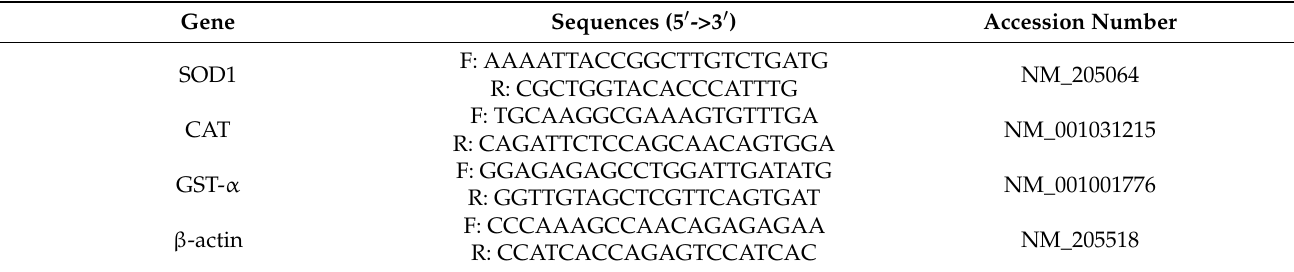
Table 1. Primer sequences for studied genes used for